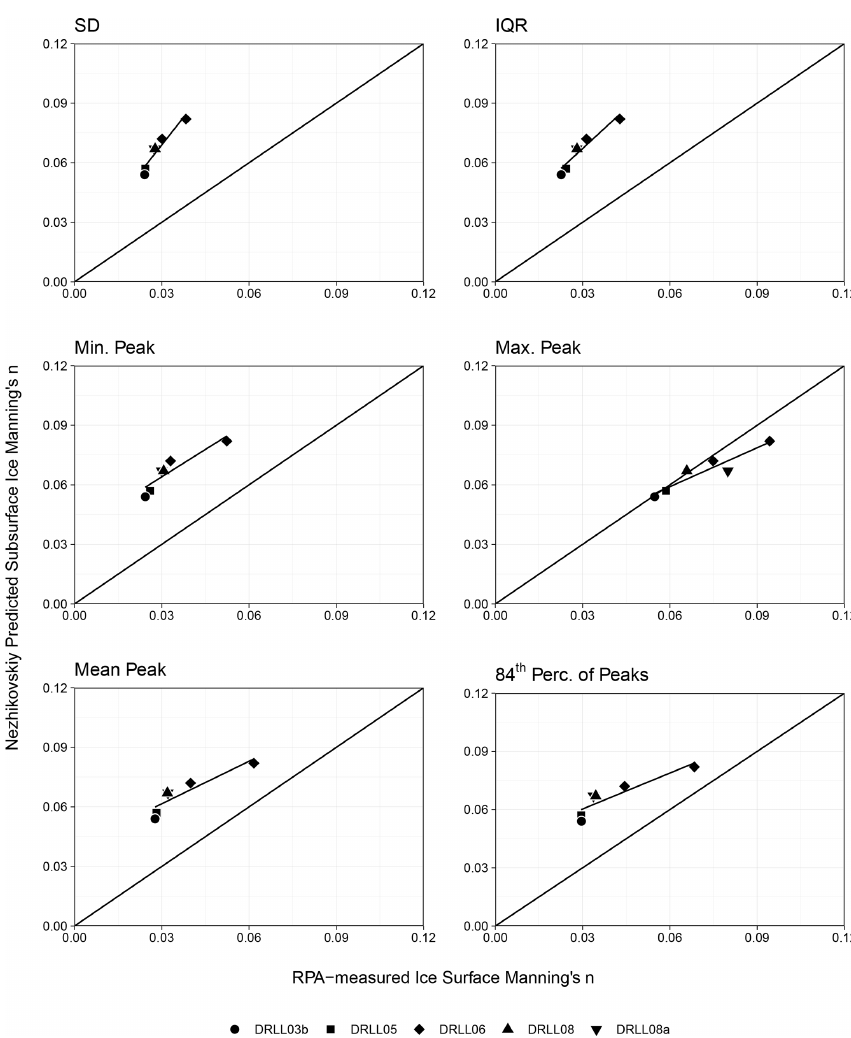
Figure 9. Comparison of RPA-measured surface ice Manning’s n calculated from various statistical metrics or roughness height to Nezhikhovskiy-predicted subsurface ice Manning’s n